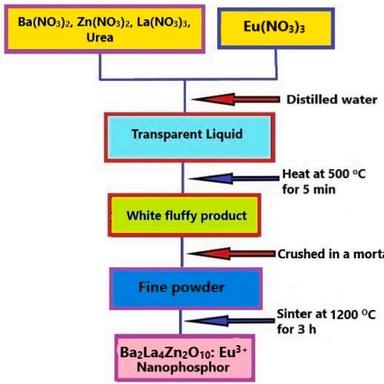
A schematic flow diagram for the fabrication of Eu3+-activated Ba2La4Zn2O10 nanophosphor.